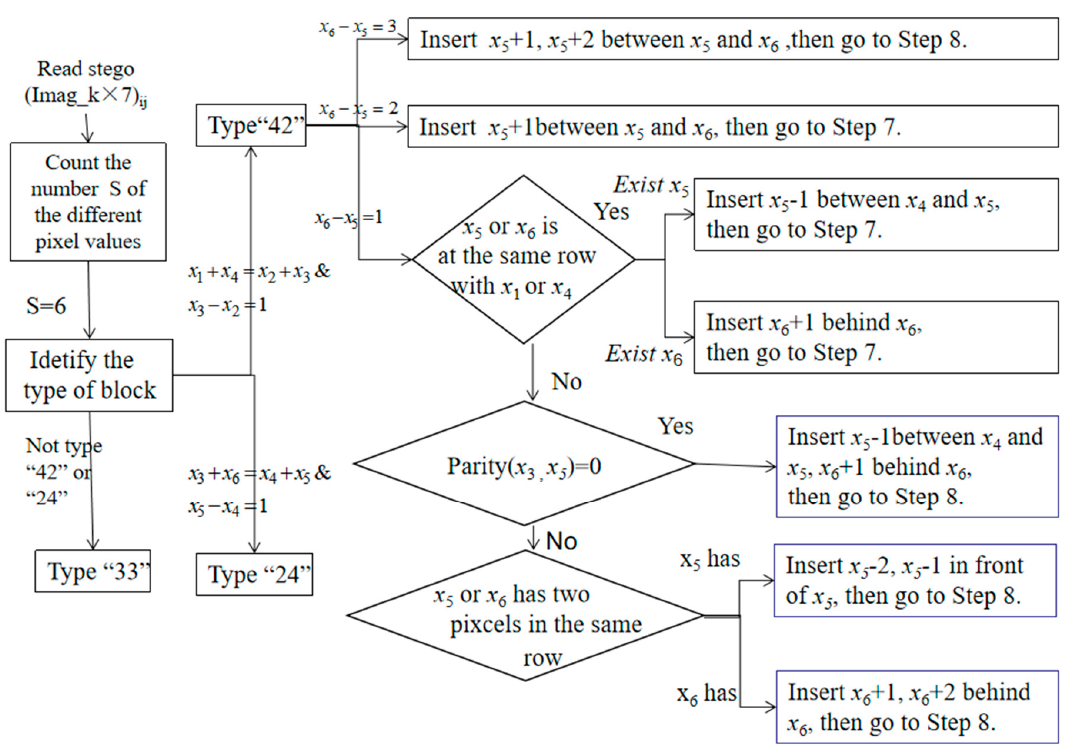
Figure 6. Flowchart of extraction phase when S = 6. Type 42, Note: S indicates the number of different pixel values.